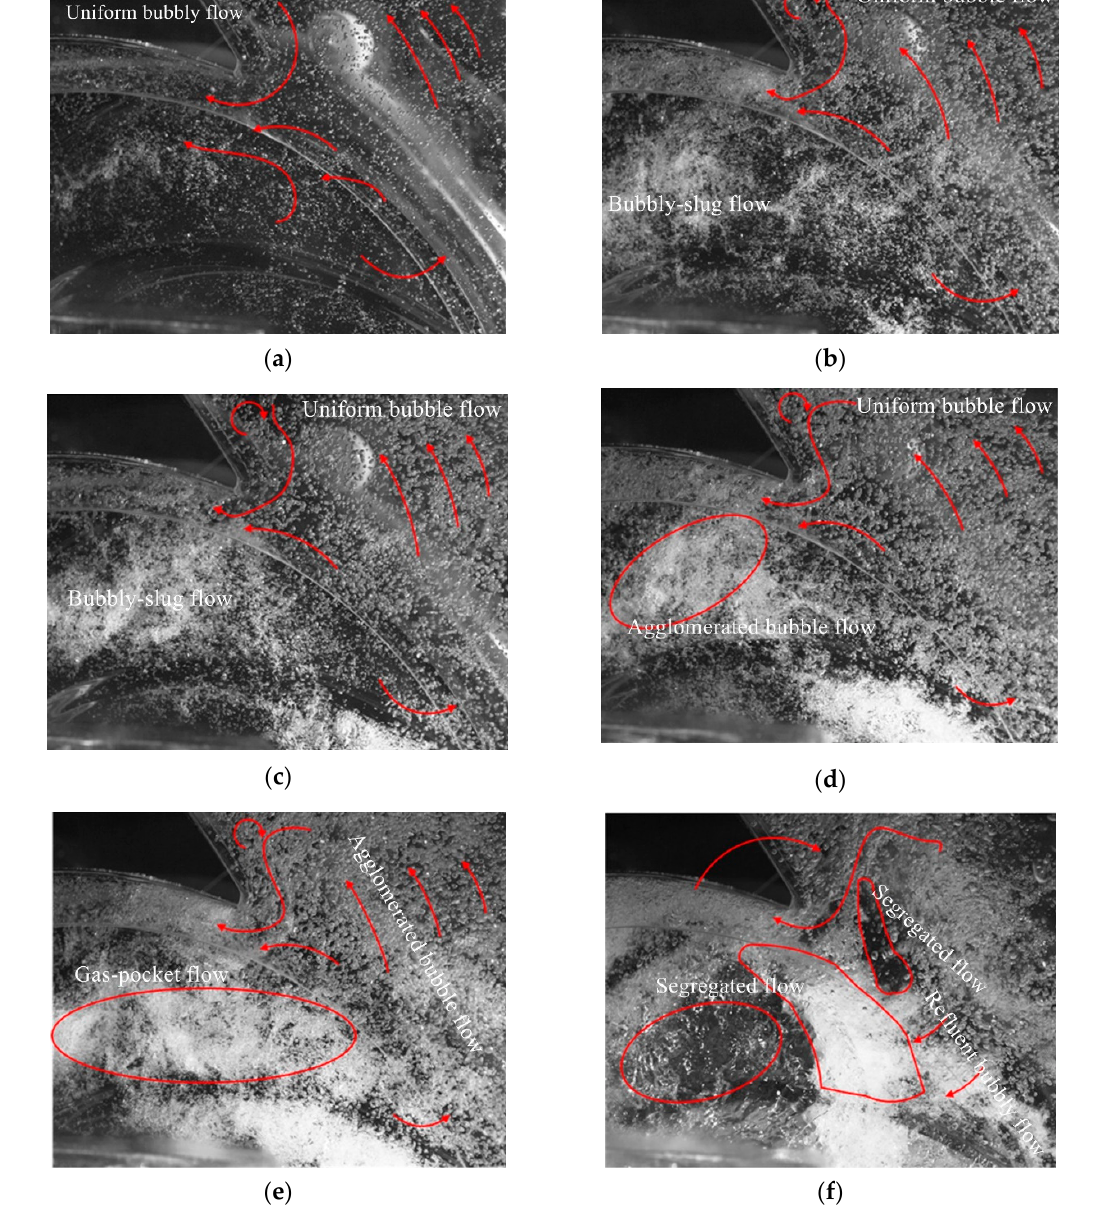
Figure 11. Flow pattern under φ = 0.06 for different α i : ( a ) 0.5%; ( b ) 1%; ( c ) 2%; ( d ) 3%; ( e ) 4%; ( f ) 4.2%, pump shut off condition.